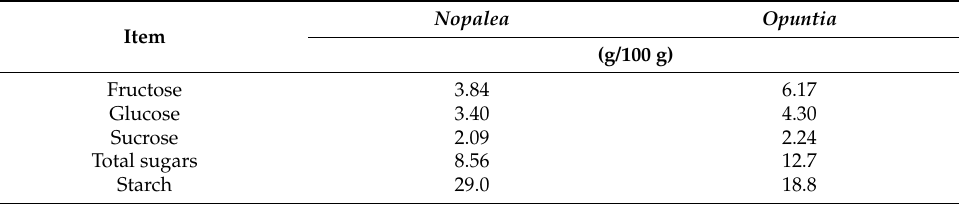
Table 2. Sugar and starch concentration of cactus cladodes.